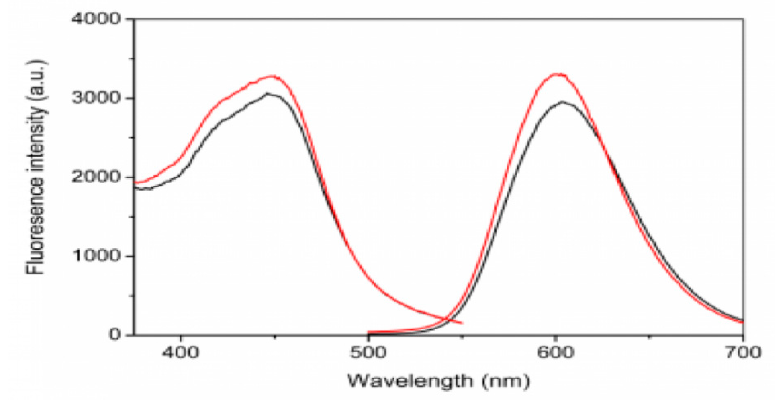
Figure 3. Fluorescent excitation (low wavelength) and emission (high wavelength) spectra of dPNP (red) and ruthenium complex epo–Ru (black).